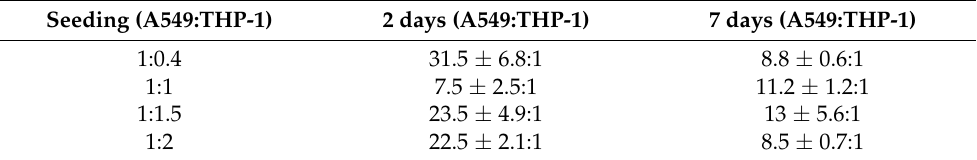
Table 1. Ratios of A549:THP-1 cells at seeding and after 2 and 7 days. Seeding